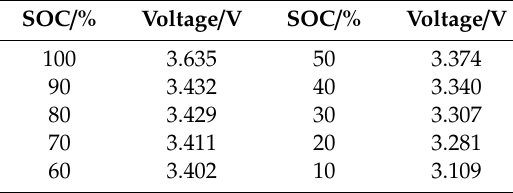
Table 1. State of charge (SOC)–open circuit voltage (OCV) discharge measurement data.